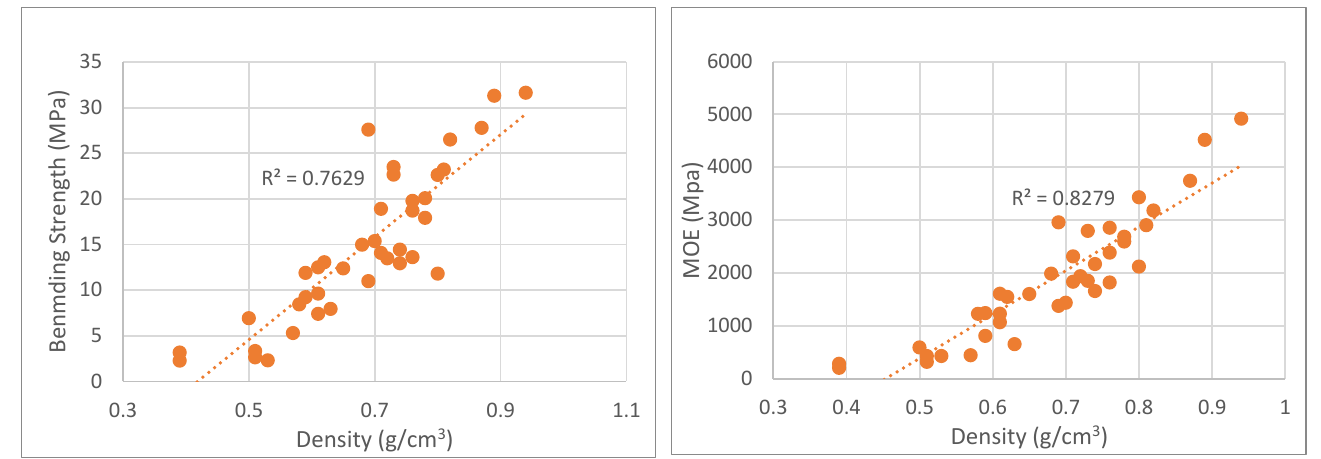
11 of 16 Figure 9. Correlation between bending strength and MOE variation with pressing temperature. 3.2. Influence of Density on Board Properties Density is most likely the major factor when addressing the board properties. Figures 10 – 13 present the variation of mechanical properties (bending strength, MOE and internal bond), water absorption, TS and thermal conductivity with density. The mechanical prop- erties of particleboards increased with the board density. Even with several different pa- rameters, it is clear that bending strength increases with density and that this increase has a linear trend. Bending strength varied between under 5 MPa for the lowest density boards to over 340 MPa for the ones with the highest density. MOE behavior followed a similar trend to bending strength ranging from 200 MPa to 5000 MPa. Similar results were presented before by several authors with different materials. For example, De Melo et al. [19] studied the board density effect on the physical and mechanical properties of parti- cleboards made from Eucalyptus grandis W. Hill ex Maiden, and they concluded that when